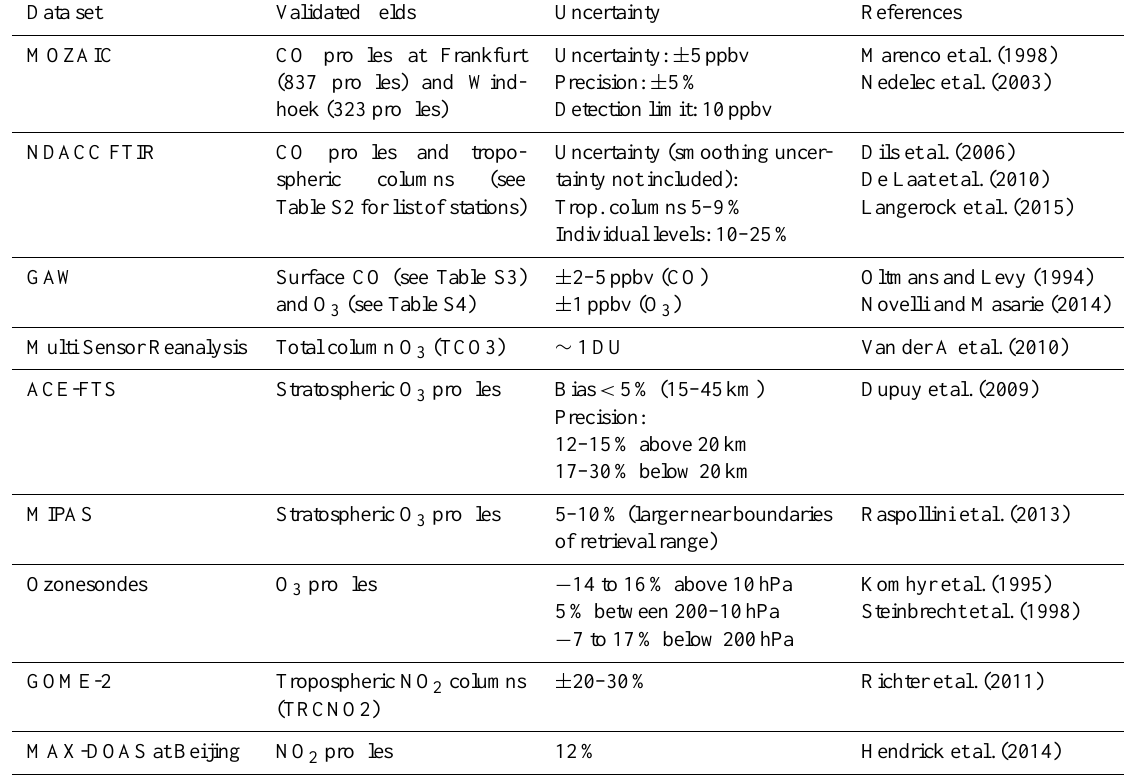
Table 2. Summary of validation data sets used in this study. A more comprehensive description of the data sets can be found in the Supple-